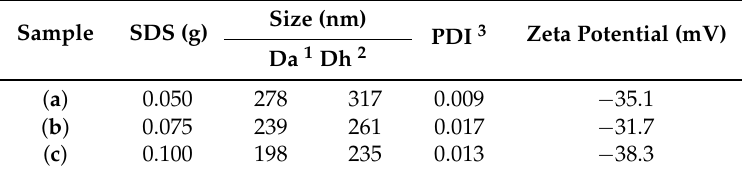
Table 1. Synthesis parameters and properties of three kinds of PS spheres.